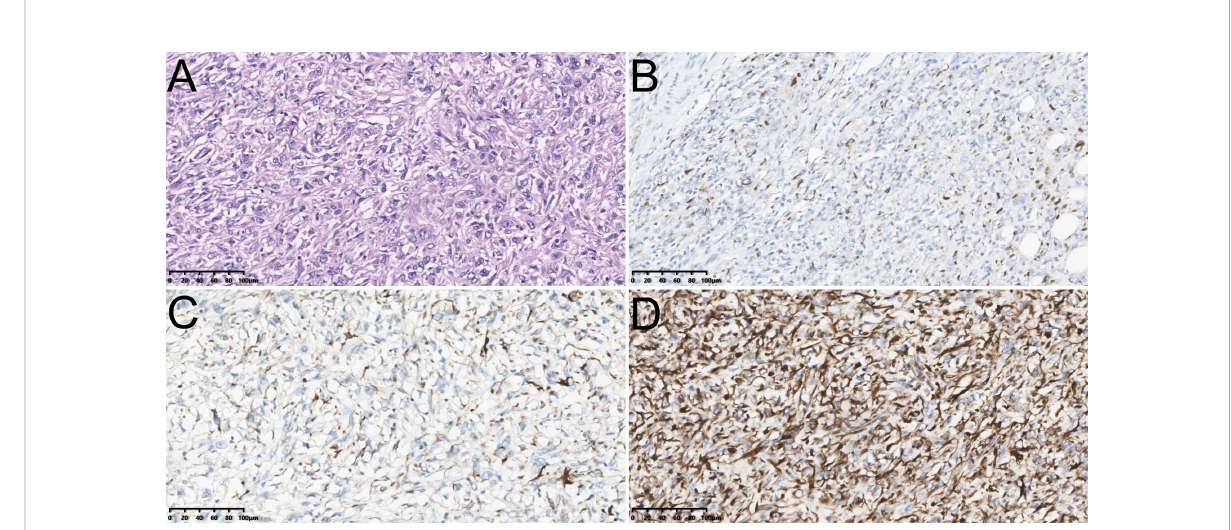
FIGURE 1 The hematoxylin-eosin (HE) staining of sarcomatoid carcinoma of gallbladder [Poor/undifferentiated, ×200, (A) ]; The immunohistochemical staining of sarcomatoid carcinoma of gallbladder including Cytokeratin (CK)7 [Positive, ×200, (B) ], Desmin [Negative, ×200, (C) ] and Vimentin [Positive, ×200, (D)